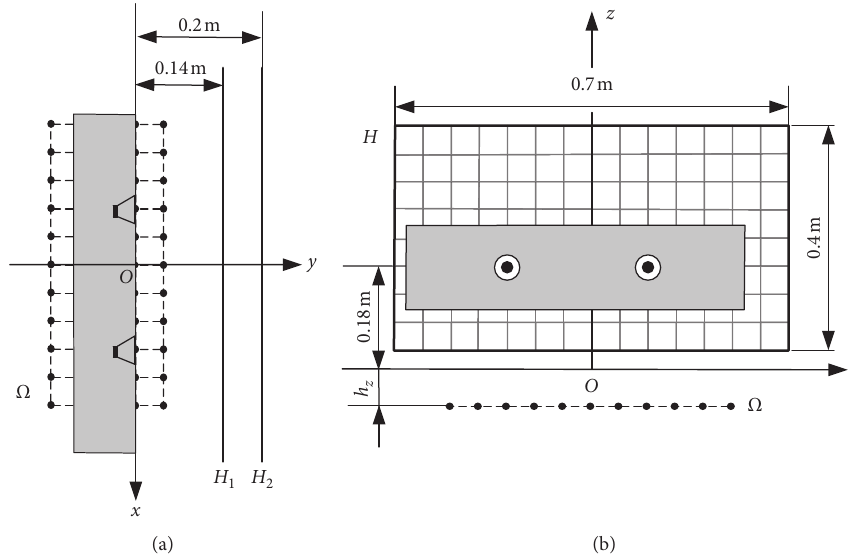
Figure 6: Location of the loudspeaker, the measurement surfaces H